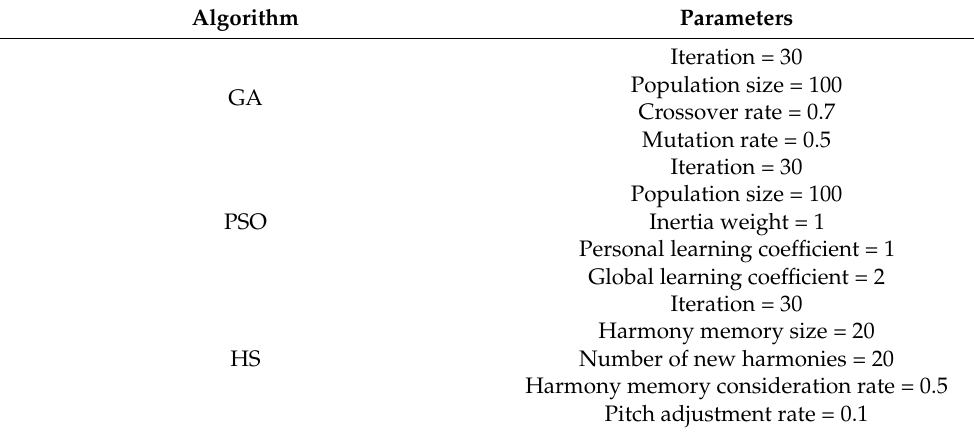
Table 3. Parameters of metaheuristic algorithms.